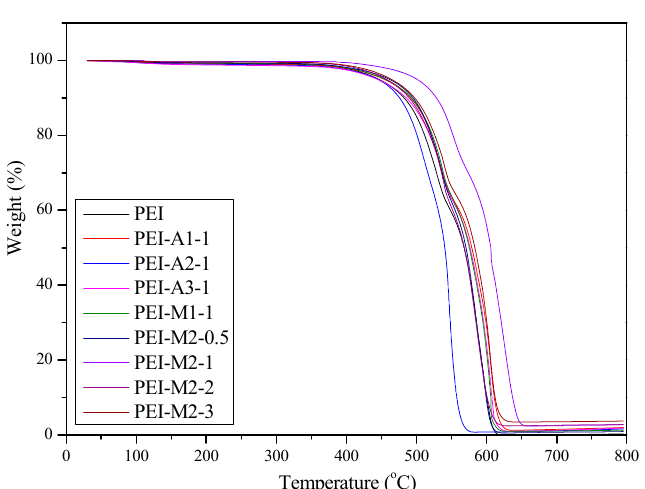
Figure 10. TGA curves for the PEI and its corresponding composite membranes containing five distinctive MSPs (A1, A1, A3, M1, and M2).